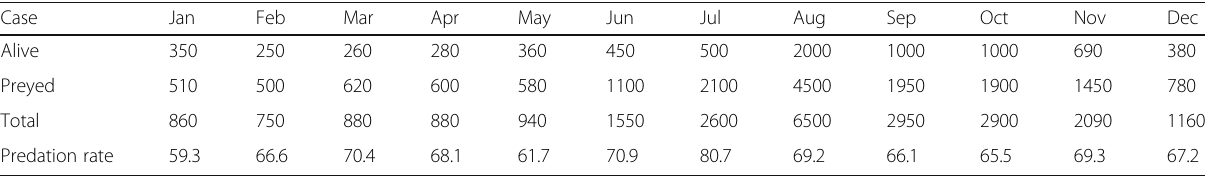
Table 4 Numbers of individuals of P. thysanopterus alive and killed by the predatory bug, M. moraguesi , (over 100 infested leaves) in the year 2017